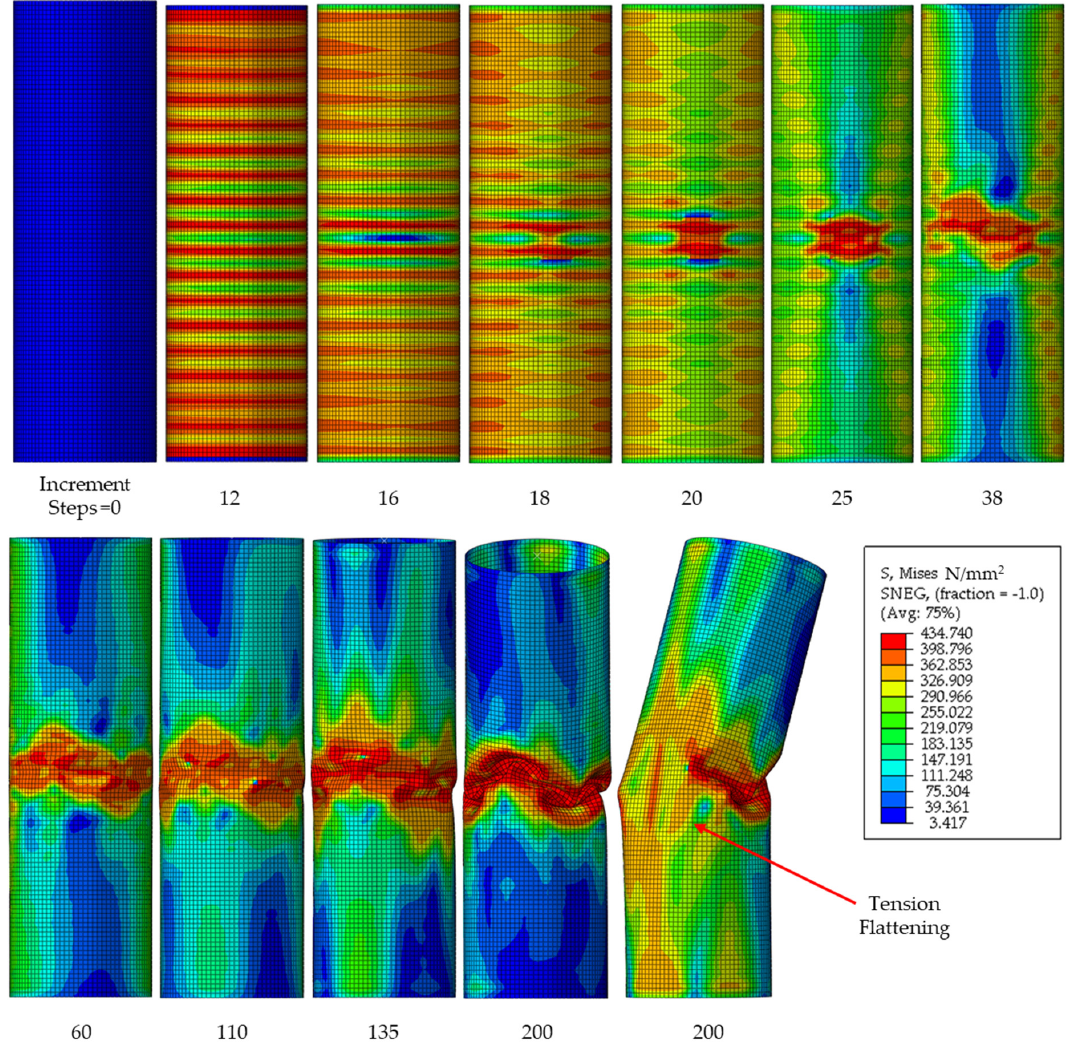
Figure 12. Shell (20 m at 24 mm) stress distributions and deformations at the compressive side of the cylindrical shell at 11 increment steps, and the view of tension side showing a flattening effect.